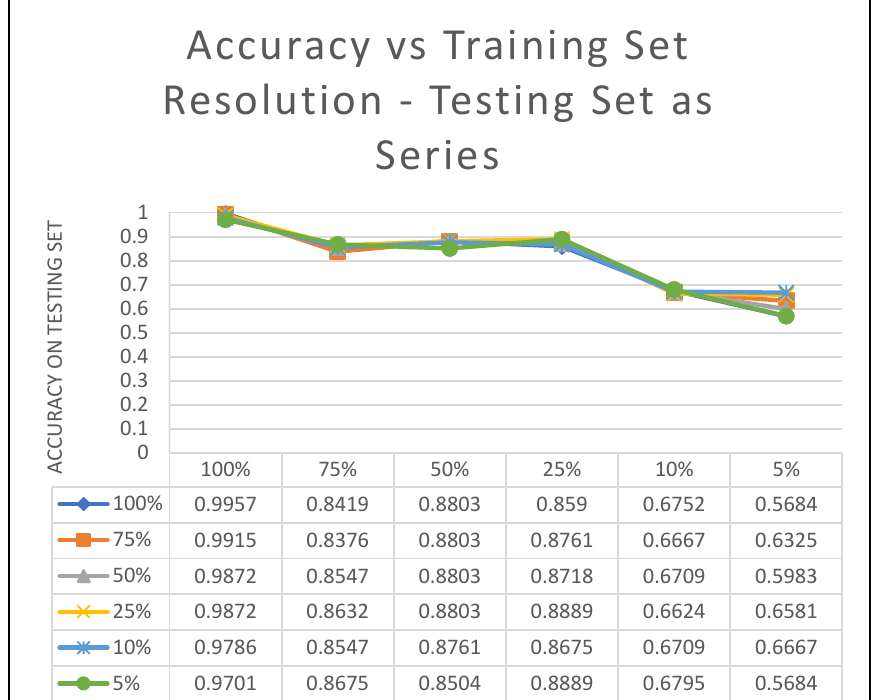
Figure 6. Each series in the graph is a different testing set resolution. The training set resolution is on the horizontal with the percentages shown as categories, and the accuracy of the testing set is on the y -axis.